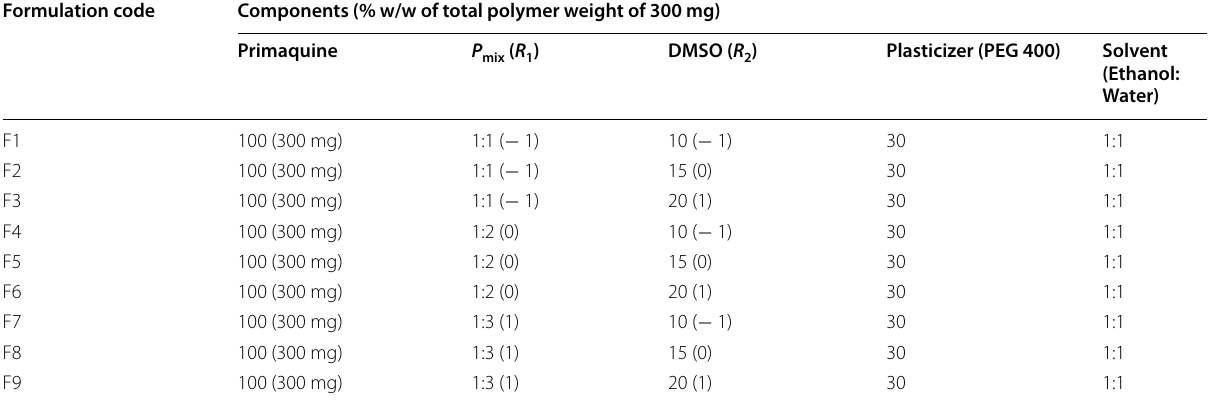
Table 3 Composition of a transdermal patch according to factorial design Formulation